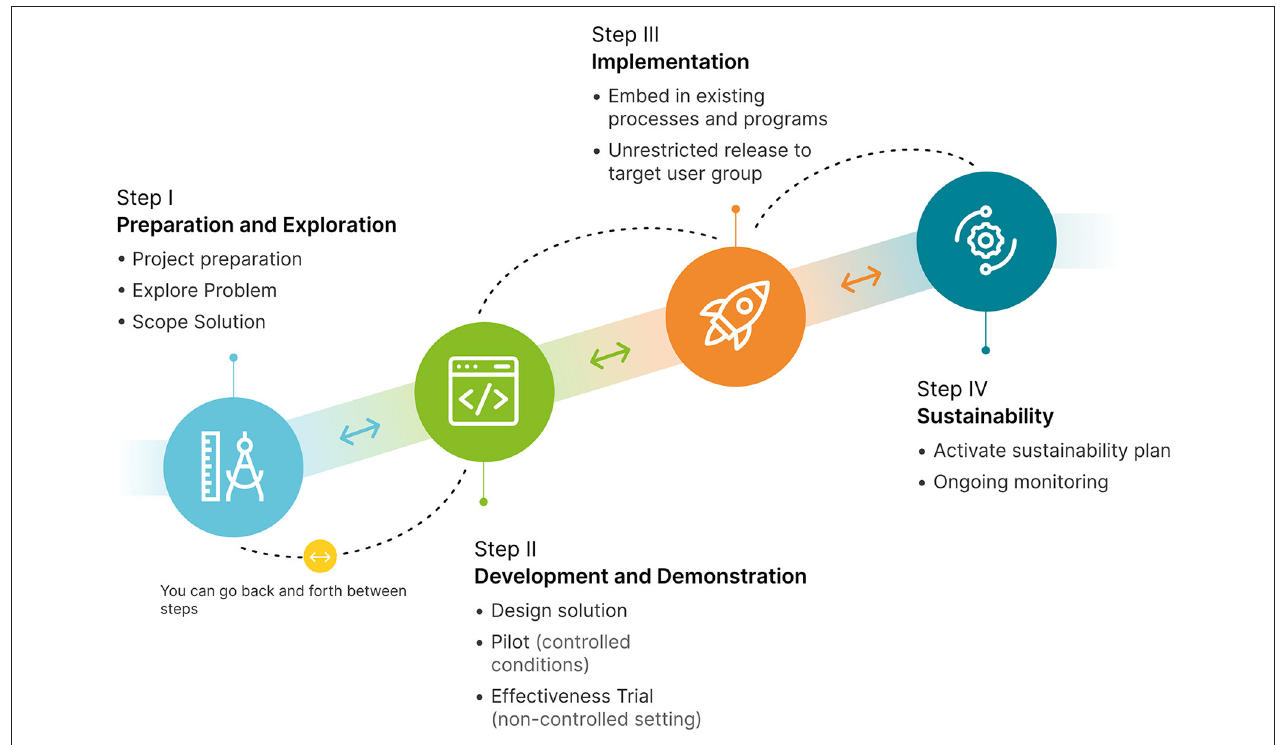
FIGURE 1 | The MCRI innovation lifecycle